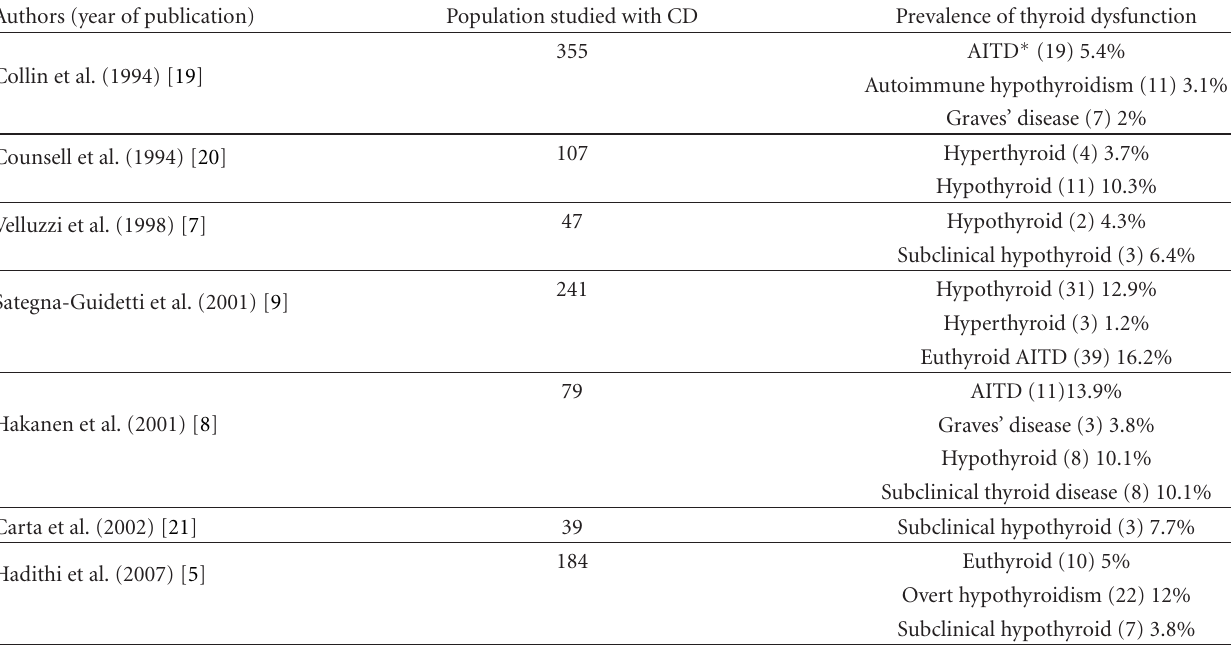
Table 4: Thyroid dysfunction in celiac disease